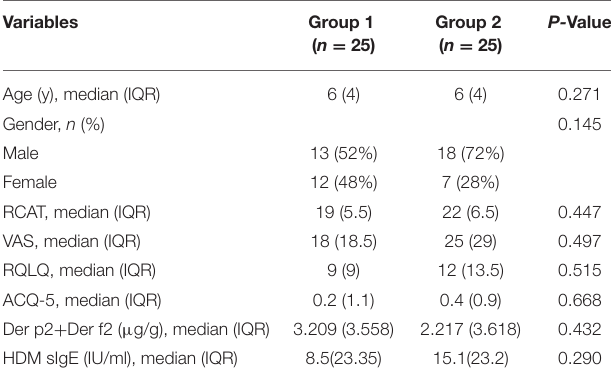
TABLE 1 | Comparison between Group 1 and Group 2 before the treatment.